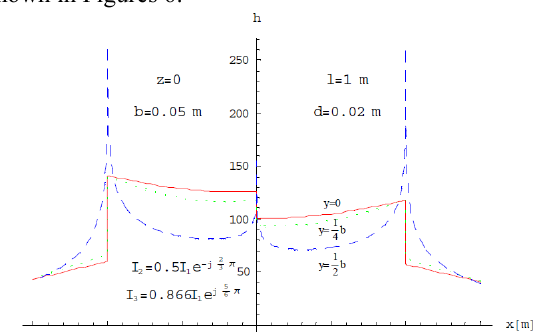
Fig. 5. Distribution of the magnetic field modulus of the three- phase line of three ribbon busbars of finite length on the plane xOy for asymmetric currents.